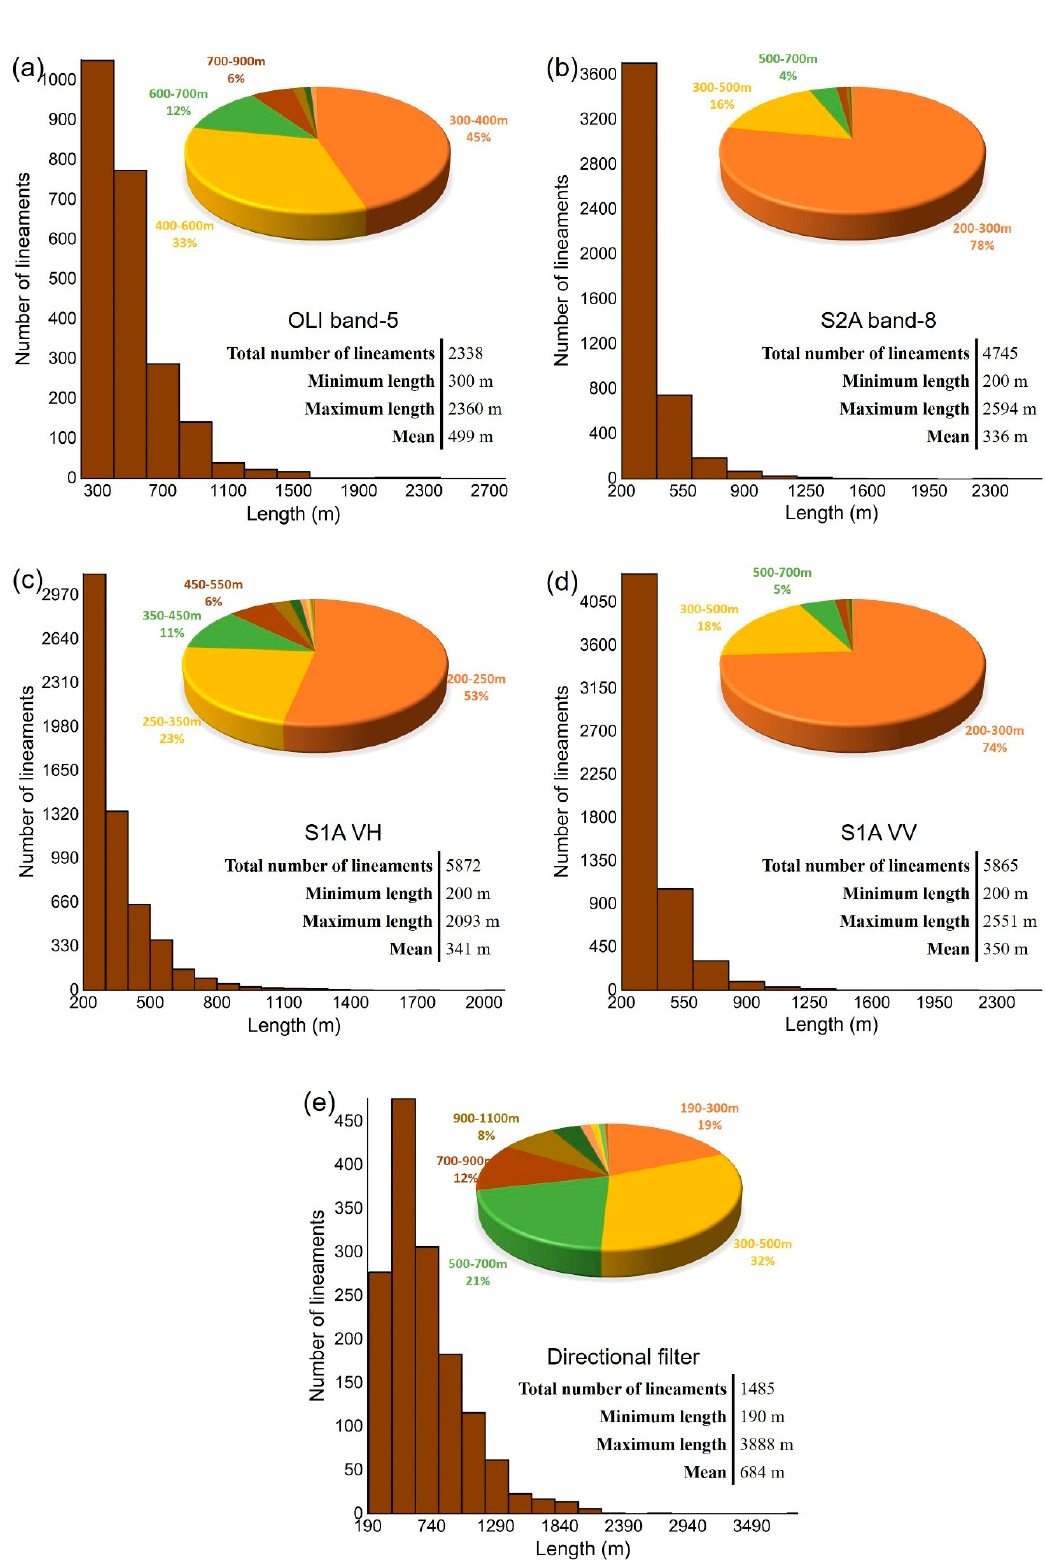
Figure 10. The distribution histograms giving information of the number of lineaments according to the length and occupational percentage for the automatically extracted ( a ) OLI band-5, ( b ) S2A band-8, and ( c , d ) S1A VH and VV polarizations respectively, as well as the manually extracted ( e ) directionally filtered RGB color composite image.